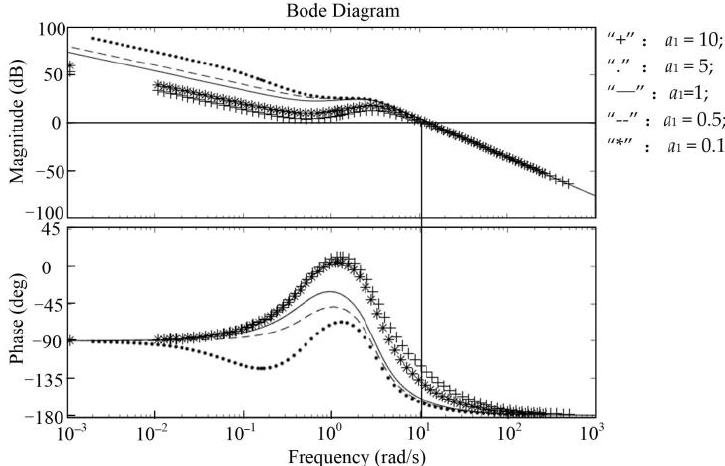
Figure 7. Bode diagram of open loop transfer function when a 1 changes.